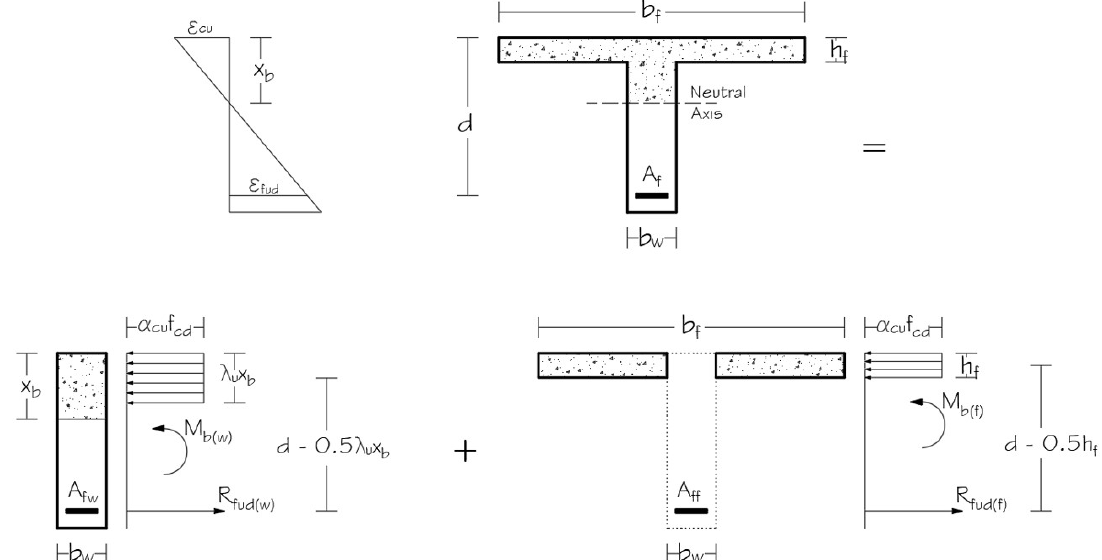
Figure 3. Compatibility and equilibrium of a balanced cross-section with the simplified stress block reaching the web